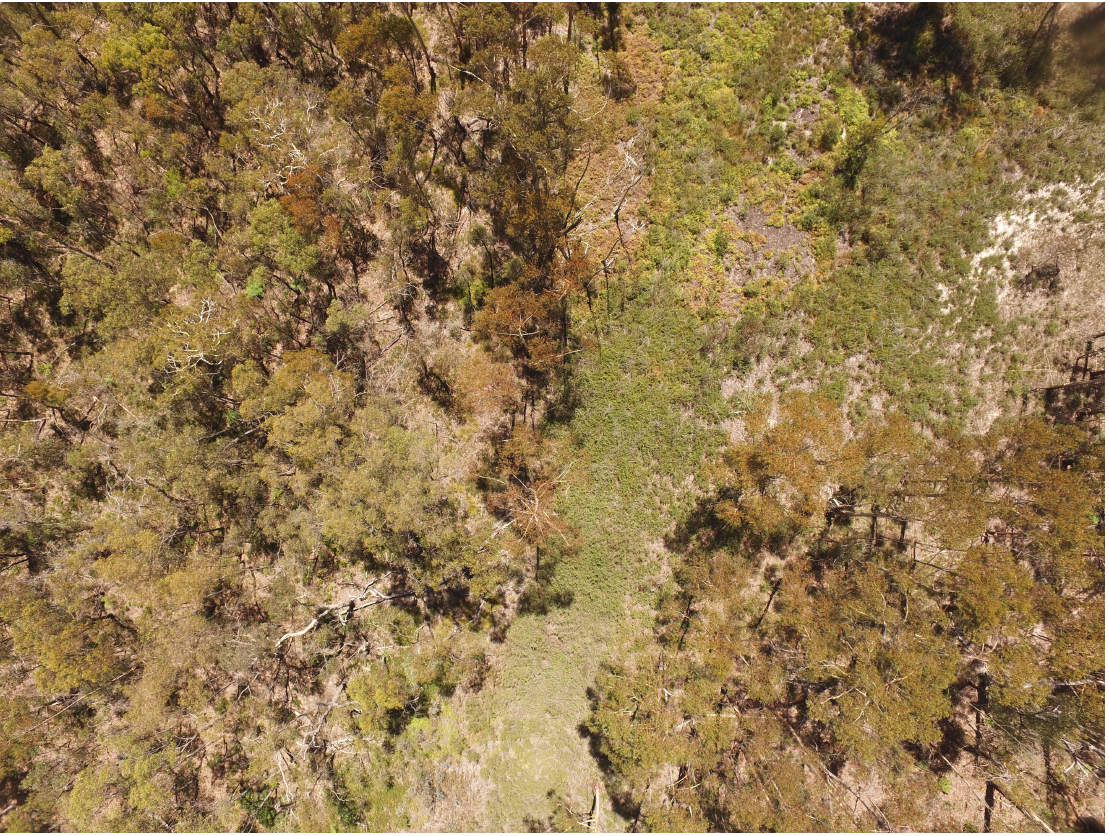
Figure 3. Image of the target community and fringing Eucalyptus forest acquired during a summer midday flight. Average resolution approximately 3 cm at ground